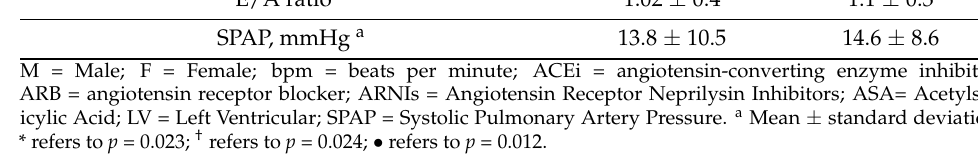
Table 2. Cont. Demographic, Medical History and Vital Signs